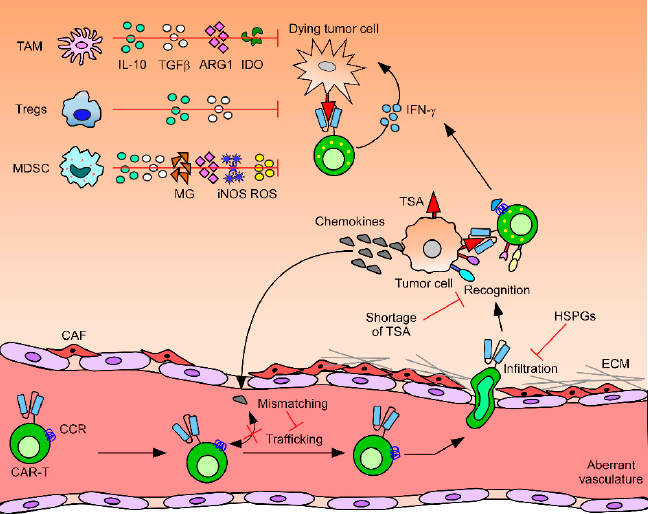
Figure 1. The journey of chimeric antigen receptor T (CAR-T) cell from the bloodstream to the tumor microenvironment and the immunosuppressive challenges it faces. A CAR-T cell starts its journey in the bloodstream, which is the common site of administration. It faces challenges regarding infiltration because of the lack of cognate chemokine signaling, aberrant vasculature, and extracellular matrix (ECM) proteins, such as heparan sulfate proteoglycans (HSPGs). Eventually, after infiltration, it encounters complications in recognizing tumors because of the shortage of TSA. It further faces an inhibitory environment because of soluble immunosuppressive factors produced by tumor-associated macrophages (TAMs), regulatory T cells (Tregs), and myeloid-derived suppressor cells (MDSCs), and its cytotoxic e ffi cacy is thus attenuated. The factors that interfere with the e ff ective anti-tumor response of CAR-T cells are controllable, either individually or in combination, to improve CAR-T cell infiltration, persistence, and cytotoxicity. CCR, cognate chemokine receptor; TSA, tumor-specific antigen; IL, interleukin; TGF β , transforming growth factor- β ; IDO, indoleamine-2,3-dioxygenase; CAF, cancer-associated fibroblast; ROS, reactive oxygen species; MG, methylglyoxal; iNOS, inducible nitric oxide